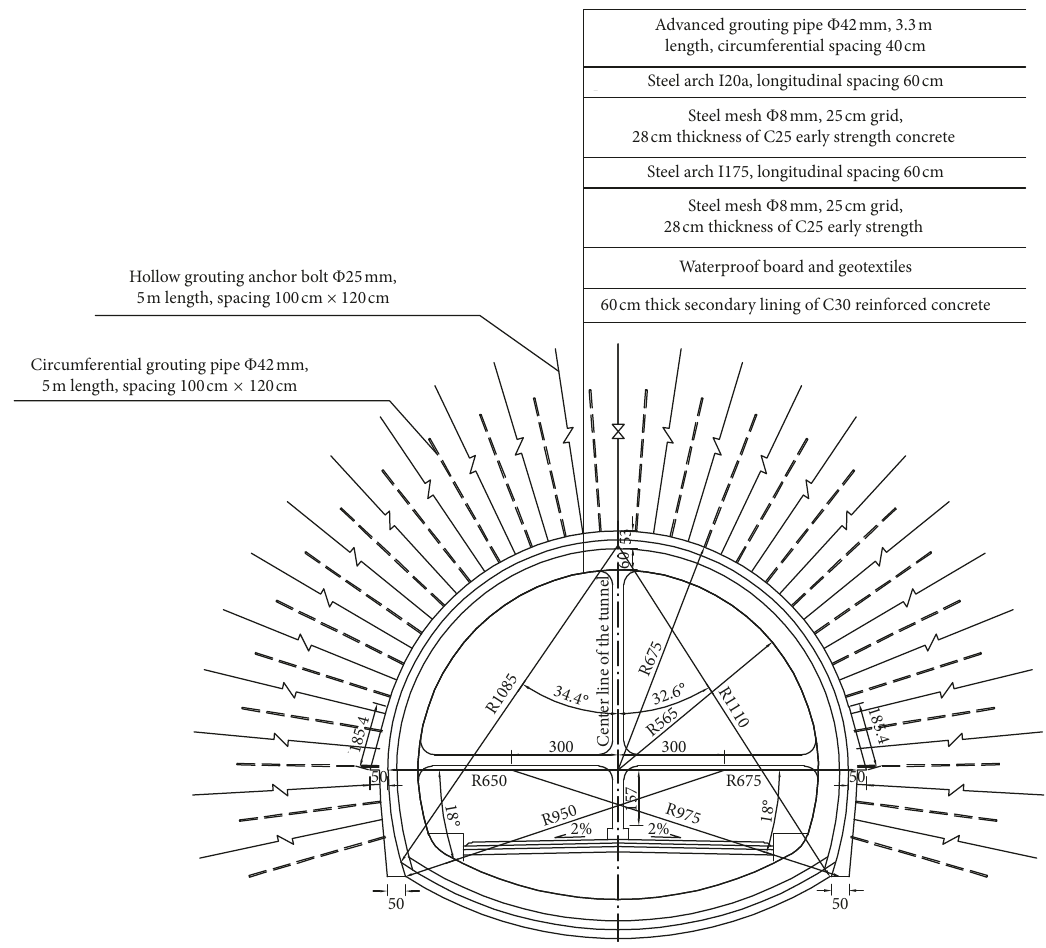
Figure 4: Form of original tunnel support